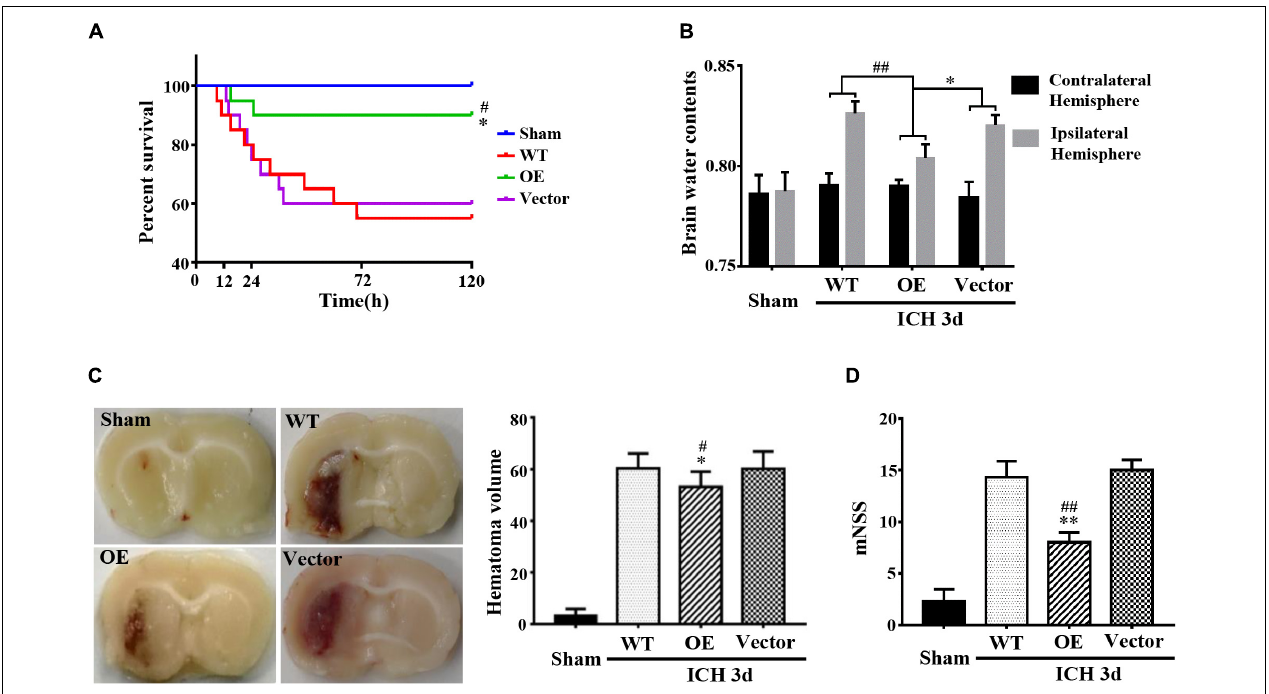
FIGURE 3 | Prdx1 overexpression alleviated the symptoms of rats after ICH. (A) Survival statistics of the sham group, WT group, Vector group, and Prdx1-OE group ( χ 2 = 14.310, df = 3, ∗ P < 0.05 versus Vector, # P < 0.05 versus WT, n = 20). (B) Brain water content of the four groups (df = 3, F = 9.324, ∗ P < 0.05 versus Vector, ## P < 0.01 versus WT, n = 6). (C) Hematoma volume of the sham group, the WT group, the Vector group, and the Prdx1-OE group (df = 3, F = 151.467, ∗ P < 0.05 versus Vector, # P < 0.05 versus WT, n = 6). (D) The mNSS was determined for four groups 3 days after ICH (df = 3, F = 75.196, ∗∗ P < 0.01 versus Vector, ## P < 0.01 versus WT, n =